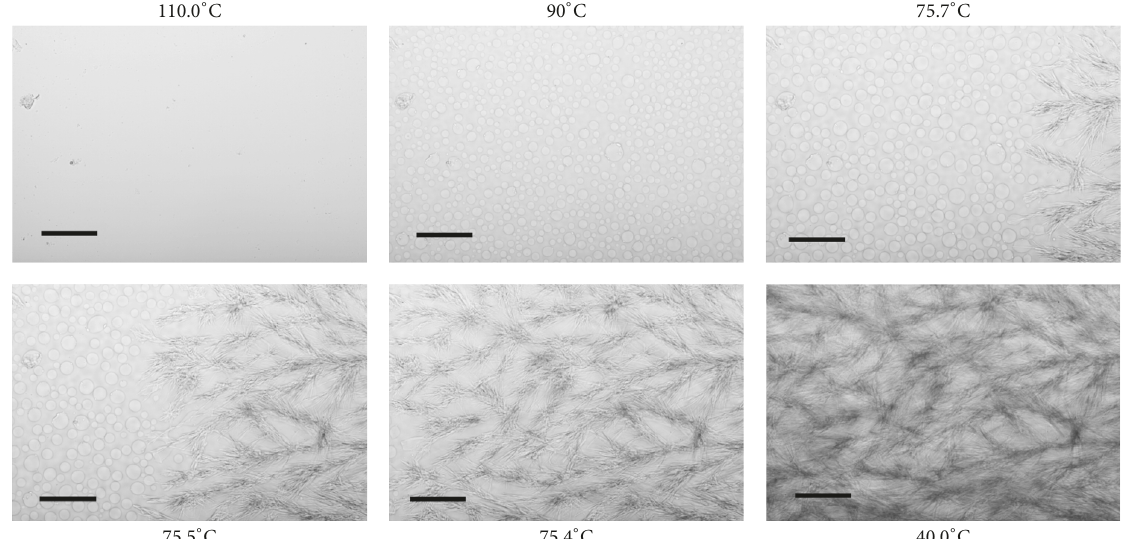
Figure 6: OM images of 3wt% 12-HSA/[ABIm][TFSI] gel during the cooling process at a rate of 0.4 ∘ C/min. The scale bar in the figure represents 100 𝜇 m.